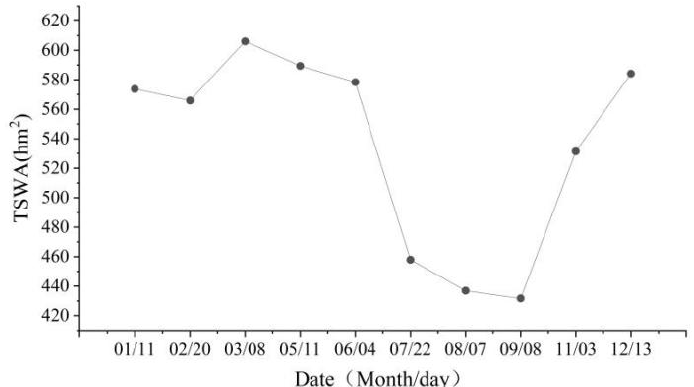
Figure 10. Month-by-month water body extraction results for 2021.